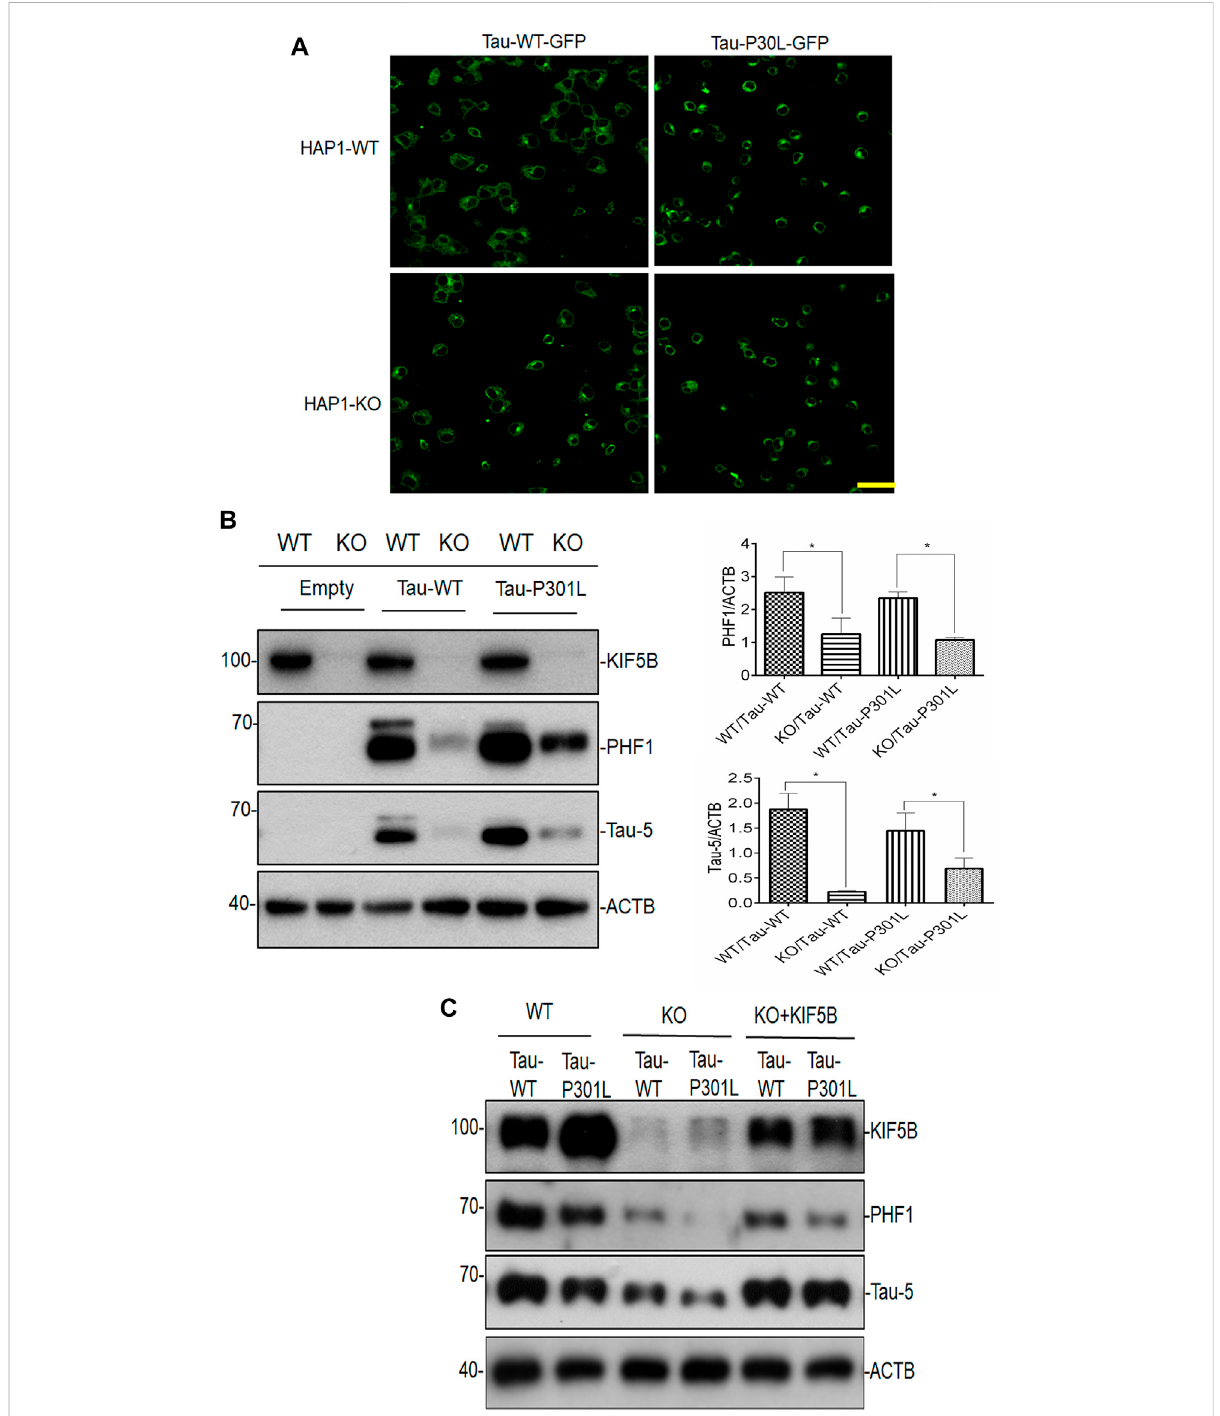
FIGURE 3 Lack of KIF5B reduces both phospho tau PHF1 and total tau. (A) Following transfection of HAP1-WT and HAP1-KO cells with plasmids encoding Tau-WT-GFPorTau-P301L-GFPoremptyplasmid,the fl uorescenceimageswererecordedusingaconfocallaserscanningmicroscope.Representative confocal images of HAPI-KO transfected cells show a decrease in fi lamentous tau aggregates, comparedwith the HAP-WT transfectedcells. The scale bar is 20 μ m. (B) The level of KIF5B, phospho t au PHF1 and total tau Tau-5 was also assessed in the transfected cells by western blotting and the signals of PHF1 and Tau-5 were quanti fi ed in the histogram using ACTB as an internal control. Histogram analysis data showed that HAP1KO but not HAP1-WT cells showed reduced PHF1 and Tau-5 levels. The data were representedas mean ± SEM of3 independentexperiments. * p < 0.05 and ** p < 0.01.* p < 0.05,*** p < 0.01signi fi cantlydifferentfromHAP-WTtransfectedcells. (C) OverexpressionofKIF5BinHAP-KOcellsincreasesPHF1andTau-5 levels.HAP-KOcellsweretransfectedwithTau-WTorTau-P301LplasmidinthepresenceorabsenceofaKIF5Bexpressionconstruct(+KIF5Baddback). The overexpression of KIF5B signi fi cantly reversed the HAP1-KO-mediated decrease in the level of PHF1 and total